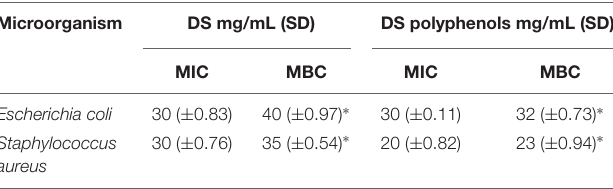
Mean and SD of results are expressed as three independent experiments in triplicates. Significant differences between each treatment and microorganism indicated as ∗ p < 0.05.